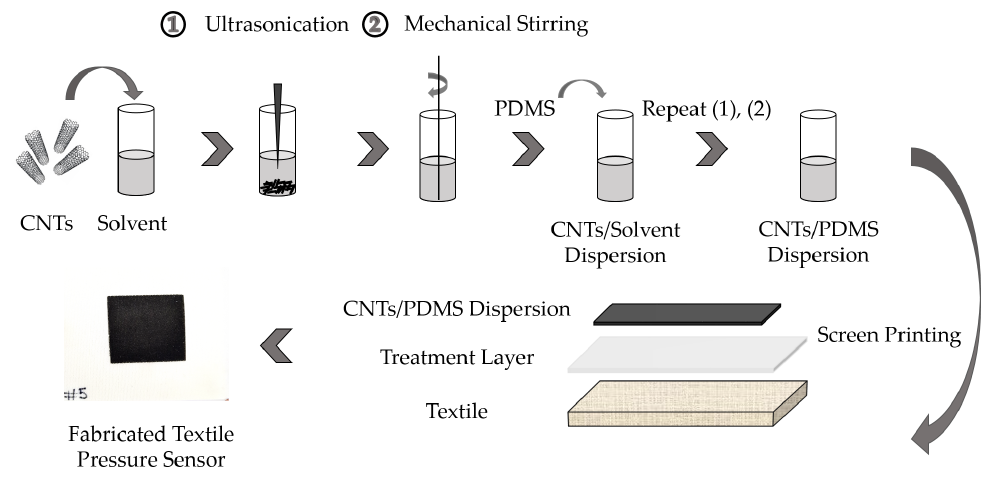
Figure 3. Preparation procedure of textile-based MWCNTs/PDMS nanocomposite pressure